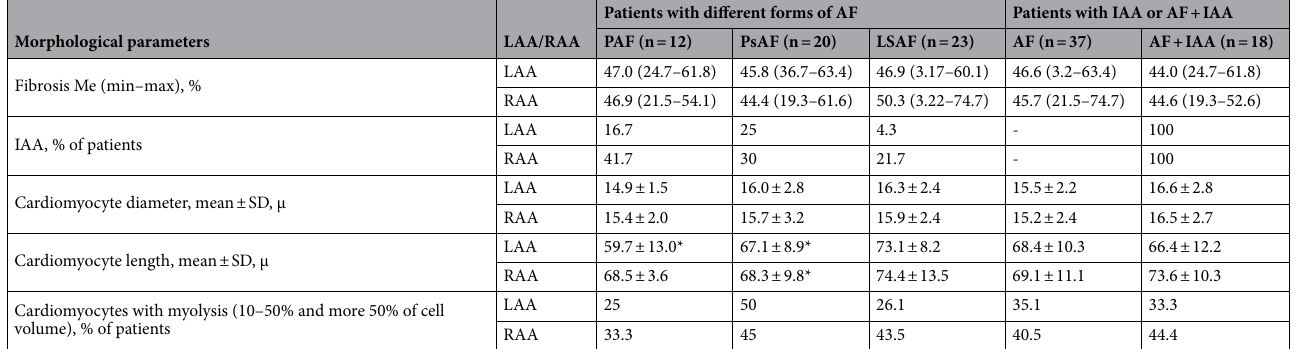
Table 1. Morphological characteristics of atrial appendages myocardium of patients with different forms of AF (PAF, PsAF, LSAF) and two groups with AF and AF + IAA. *Comparison with LSAF, Mann–Whitney U Test p <